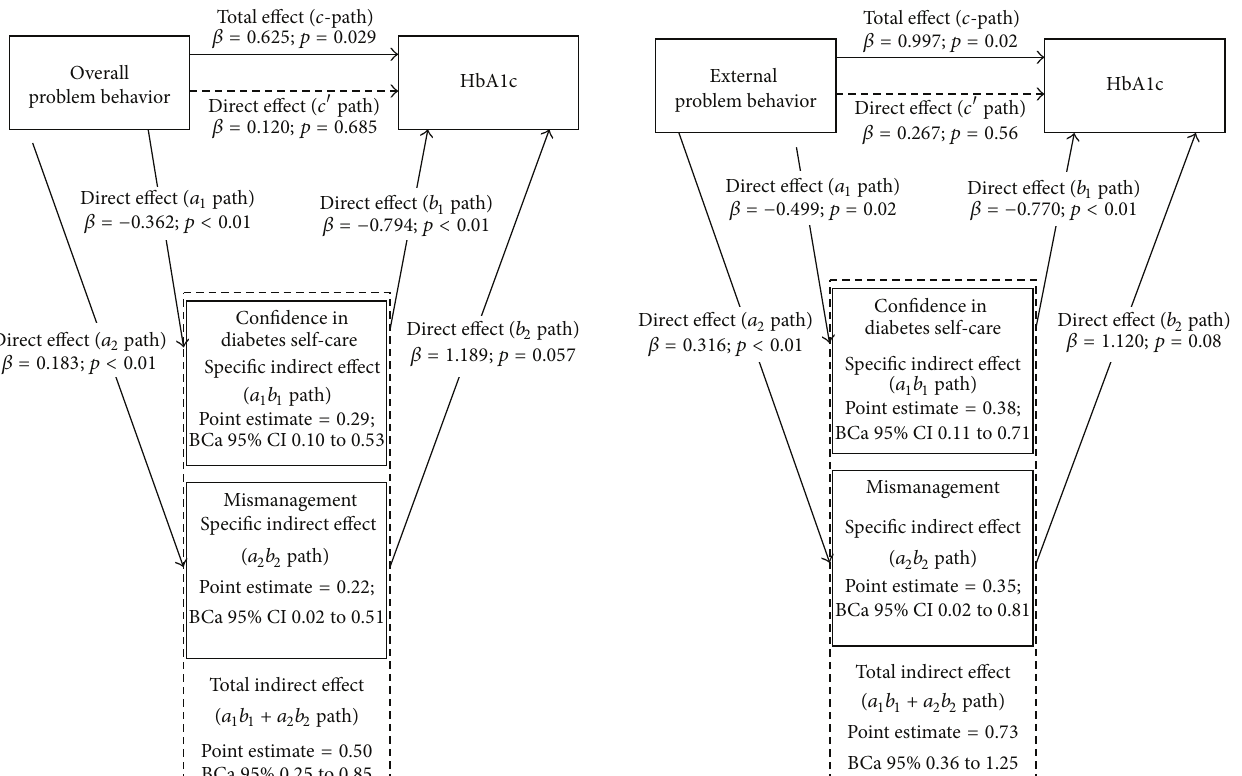
Figure 2: Graphic representation of the multiple mediation model of the associations between external problem behavior and glycemic control. 5000 resamples were calculated while using the bootstrap method